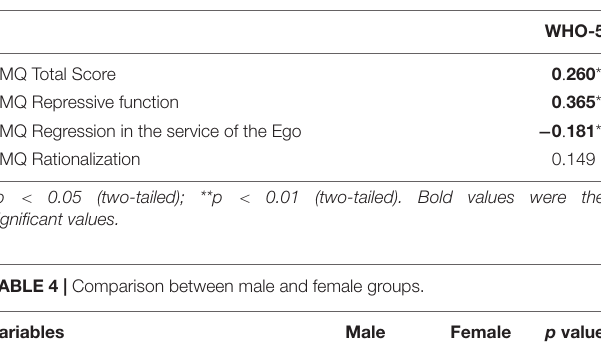
TABLE 3 | Correlation coefficients among SMQ and WHO-5 factors.